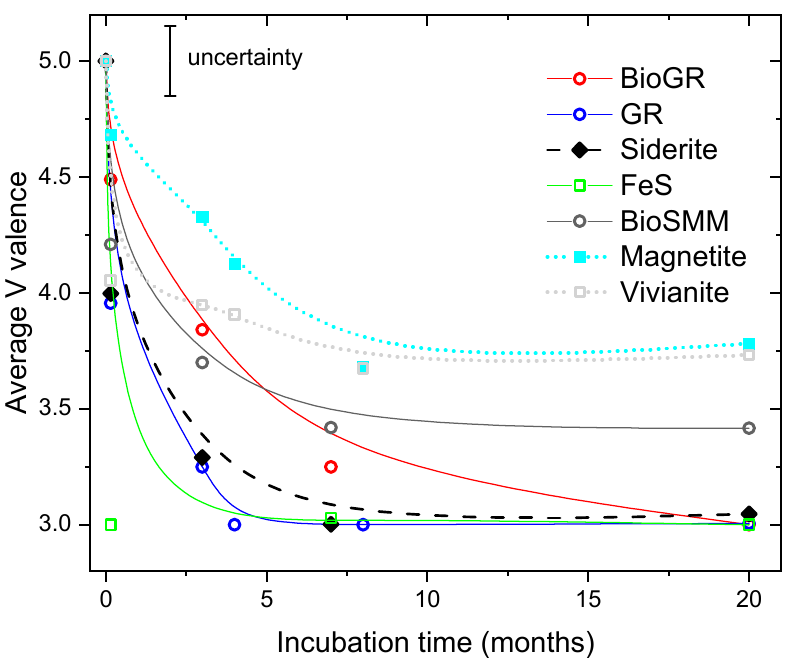
Figure 10. Average V valence over time in each of the Fe(II)-containing systems, calculated using the refined component weights in the LC fits of the XANES data (V_valence = 3x 3 + 4x 4 + 5x 5 , where x 3 + x 4 + x 5 = 1 are the weights of the corresponding valence components). The uncertainty in average V valence determination is estimated at ± 0.15 by propagating the ± 7% uncertainty in x i reported in Table 1, and is illustrated above as a single error bar for all points. The lines are B-spline interpolations to the data points, intended as a guide to the eye.